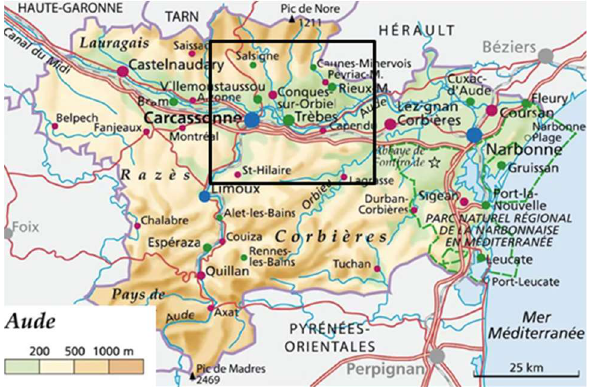
Figure 1 . Study area in Aude Department, France ( l-itinéraire ).